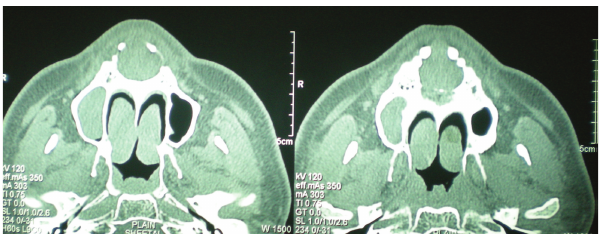
Figure 3: Axial sections of CT scan showing the well-defined round radiolucency.